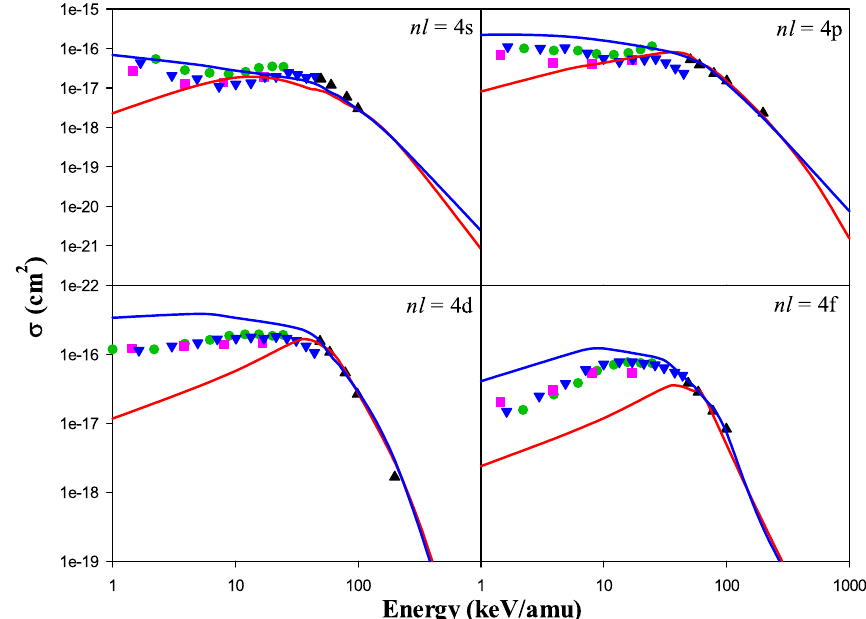
Figure 5. Electron capture cross sections into 4 s , 4 p , 4 d , and 4 f states of the projectile in Be 4+ + H(1 s ) collision, as a function of the impact energy. Solid red line: present CTMC results, solid blue line: present QCTMC results, pink squares: AOCC results of Fritsch 5 , green circles: QMOCC results of Harel et al. 4 , black triangles: BCCIS results of Das et al. 14 , blue inverse triangles: OEDM results of Errea et al. 13